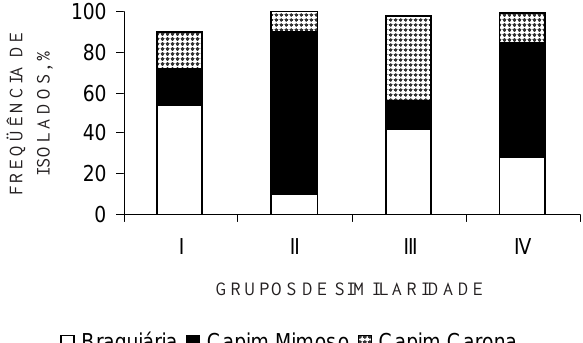
Figura 4. Freqüência dos isolados de A. brasilense , A. lipoferum , A. amazonense e H. seropedicae cada grupo de similaridade formado pela restrição da região 16S DNAr em três espécies de plantas forrageiras do Pantanal do Mato Grosso do